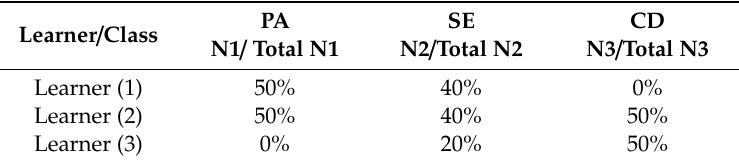
Table 10. Sample of FCS learners’ participation